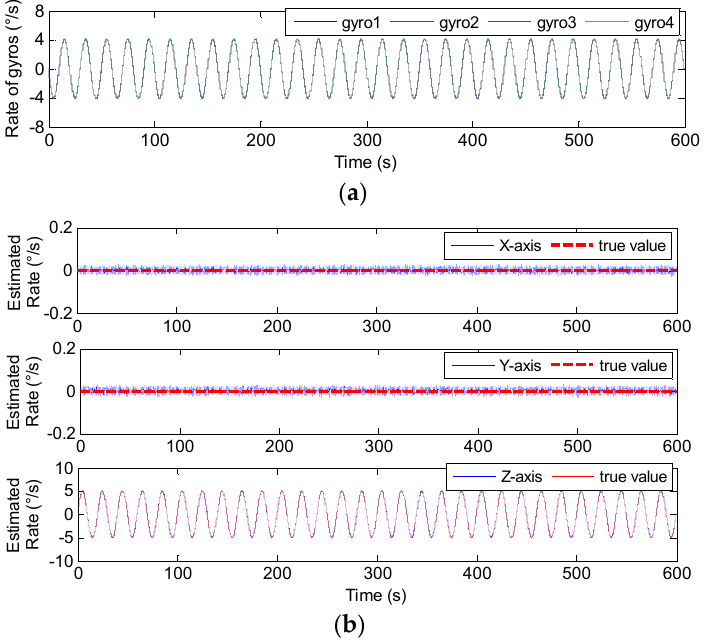
Figure 23. The swing test results of 4-MIMU with ω z = 5 × sin(2 π ft )° /s ( f = 0.05 Hz). ( a ) The outputs of gyros. ( b ) The estimated rate of the MIMU on the X b , Y b and Z b axes.